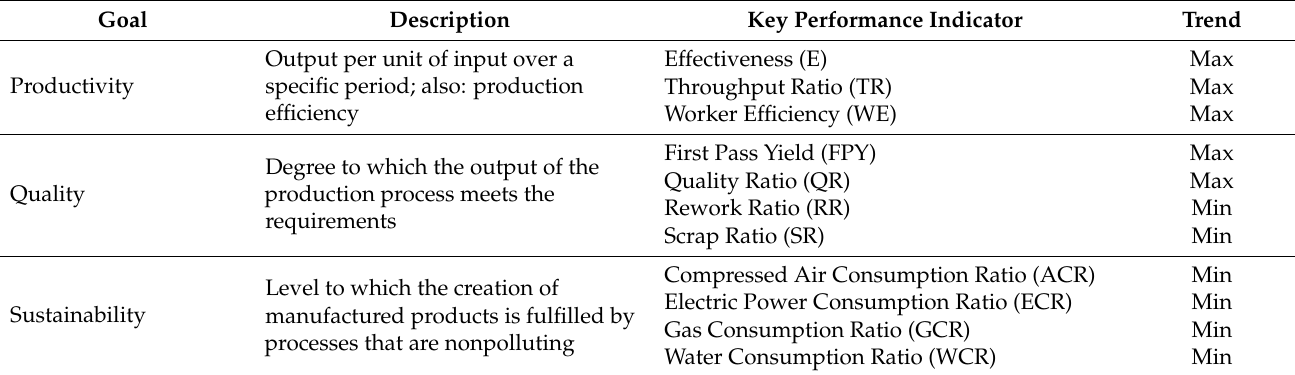
Table 5. Technical goals when implementing 5G technology for BLISK milling